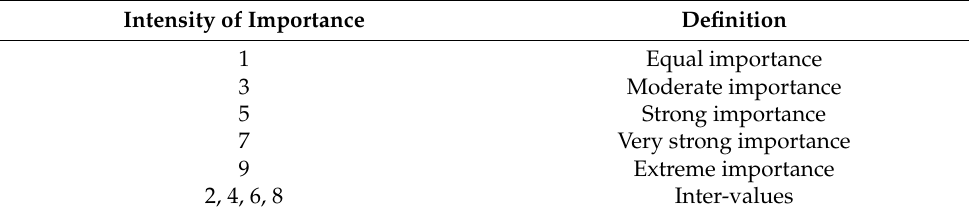
Table 1. Fundamental scale in the AHP ranking